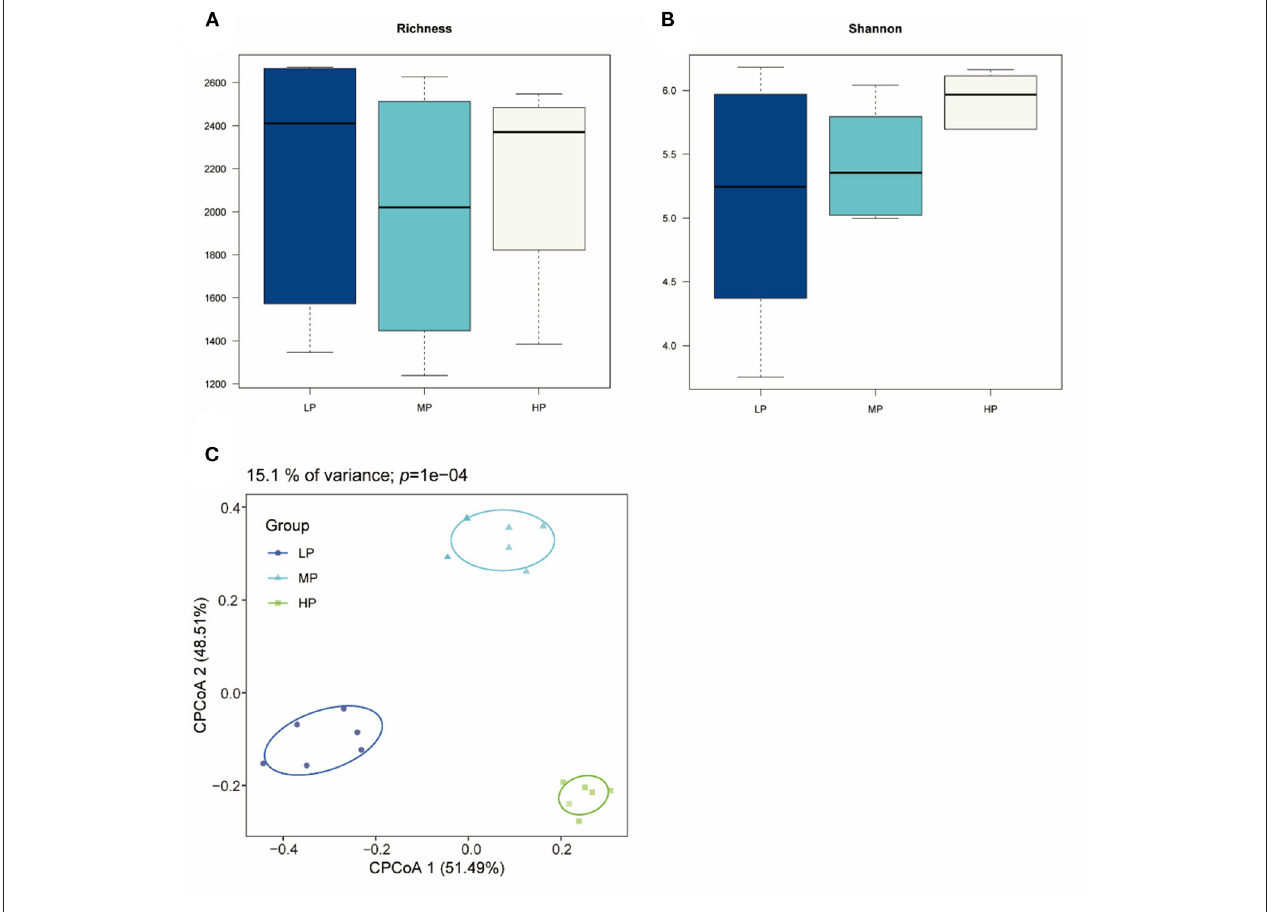
FIGURE 1 | Bacterial diversity of rumen fluid samples among three different groups. (A) Richness index; (B) Shannon index; (C) CPCoA plot based on